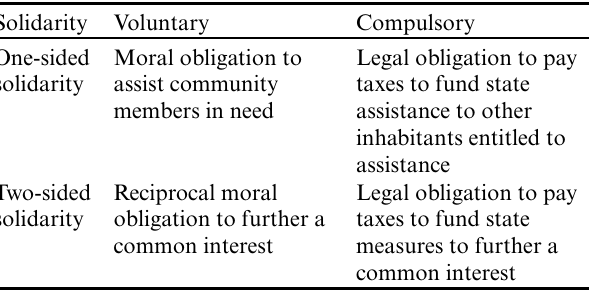
Table 1 . Ideal types of